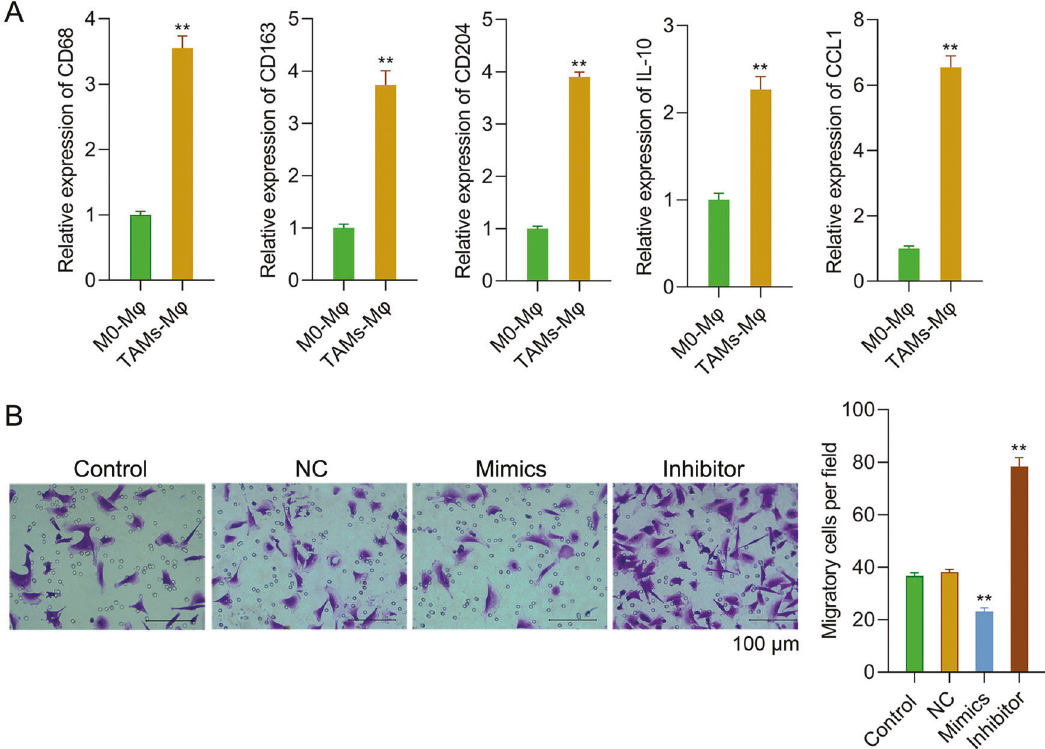
Fig. 1 TAM-like macrophages were successfully induced, and different expressions of miR-363 in MG-63 cells in fl uenced TAMs migration. A CD14 + PBMCs were stimulated by hM-CSF and an osteosarcoma-conditioned medium. qPCR was used to test CD68, CD163, CD204, IL-10, and CCL1 expressions in cells. B TAMs were added into the upper-chamber, while MG-63 cells transfecting miR-363 mimics or inhibitors were put into the lower-chamber. Forty-eight hours later, the migration of TAMs was detected. **P < 0.01 vs. M0-M φ or NC